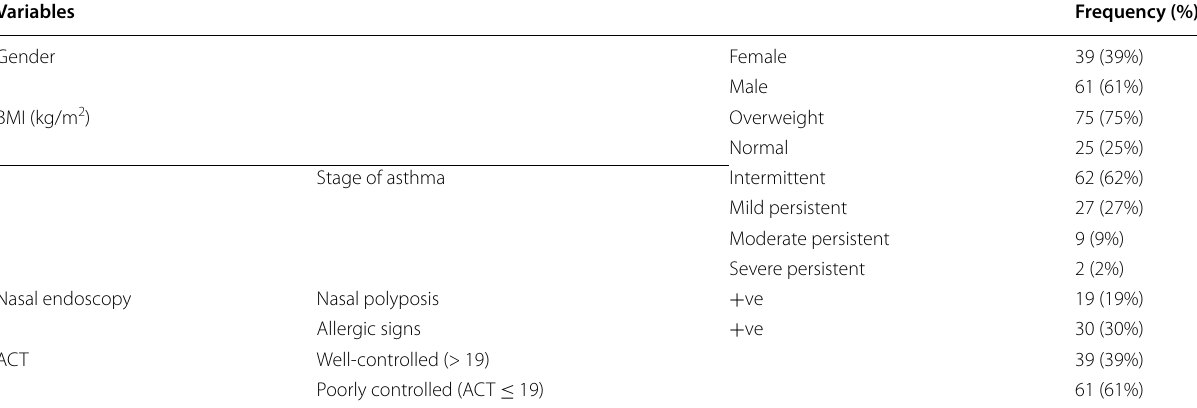
Data are mean standard deviation (SD) or number ( n ) and percentage (%). ACT Asthma Control ±